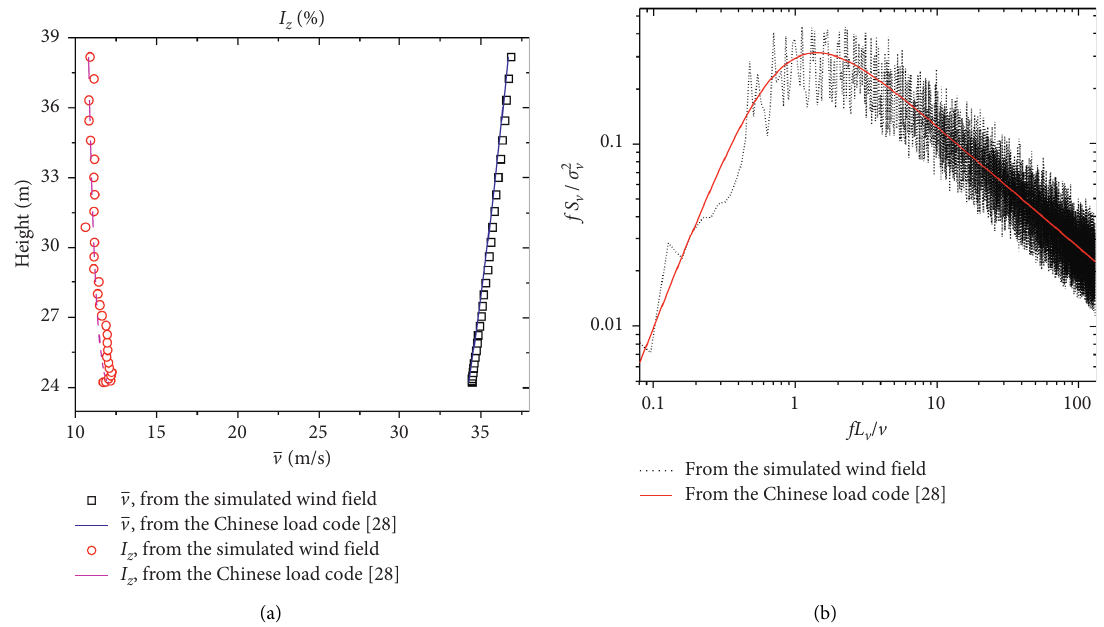
Figure 4: Comparison of the simulated values and the calculated values of the Chinese load code for the wind field characteristics for Category B ground roughness (GB 50009-2012, 2012). (a) Average wind speed ( v ) profile and turbulence intensity ( I z ) profile. (b) Nondimensional wind speed spectrum at 38.168m